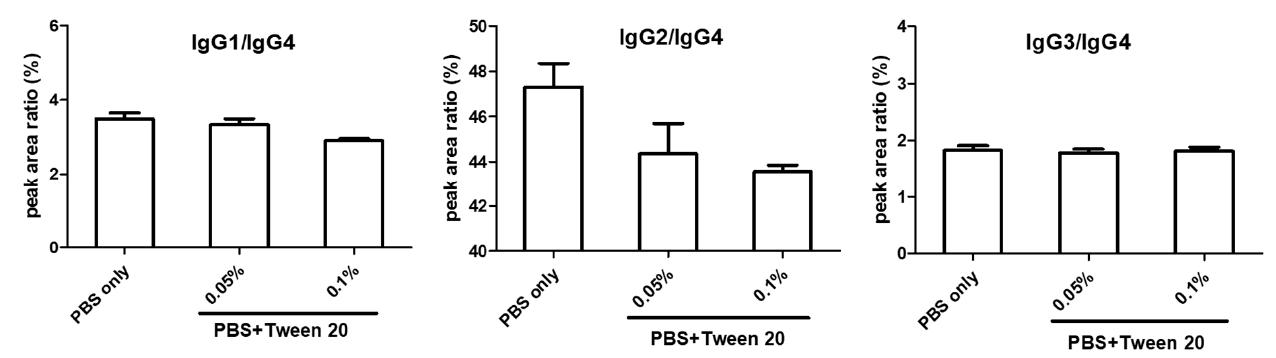
Figure 2. Optimization of wash step after sample incubation. Peak area of surrogate peptides of IgG1, IgG2, and IgG3 were divided by peak area of IgG4 surrogate peptide to investigate the effects of different wash solutions.